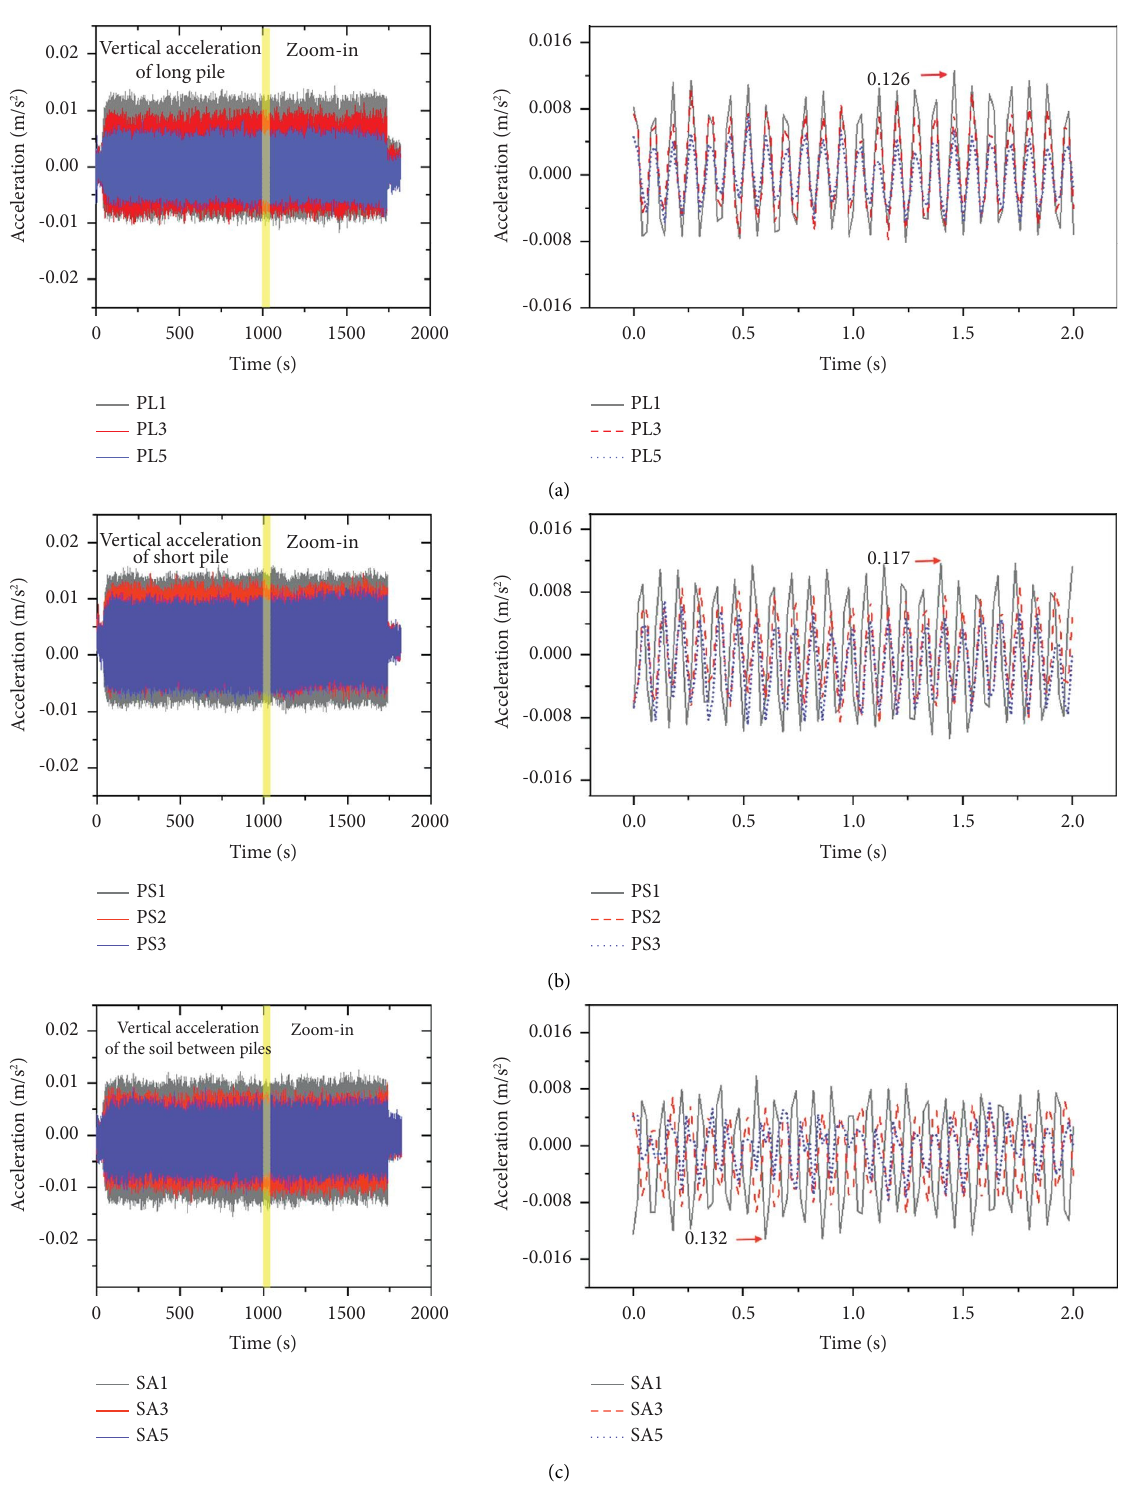
Figure 5: Time-history response curve of acceleration. (a) Time domain curve of acceleration response of long pile. (b) Time-domain curve of acceleration response of short pile. (c) Time-domain curve of the acceleration response of soil between 240 km/h speed is shown in Figure 9. Te left side is the